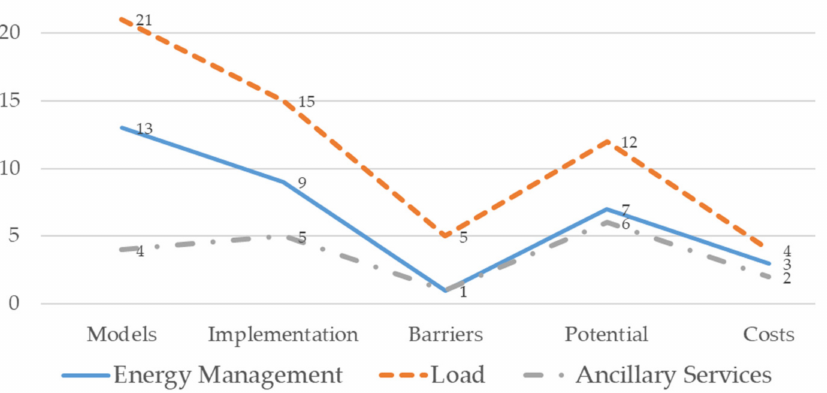
Figure 7. Distribution of keywords within the selected demand response